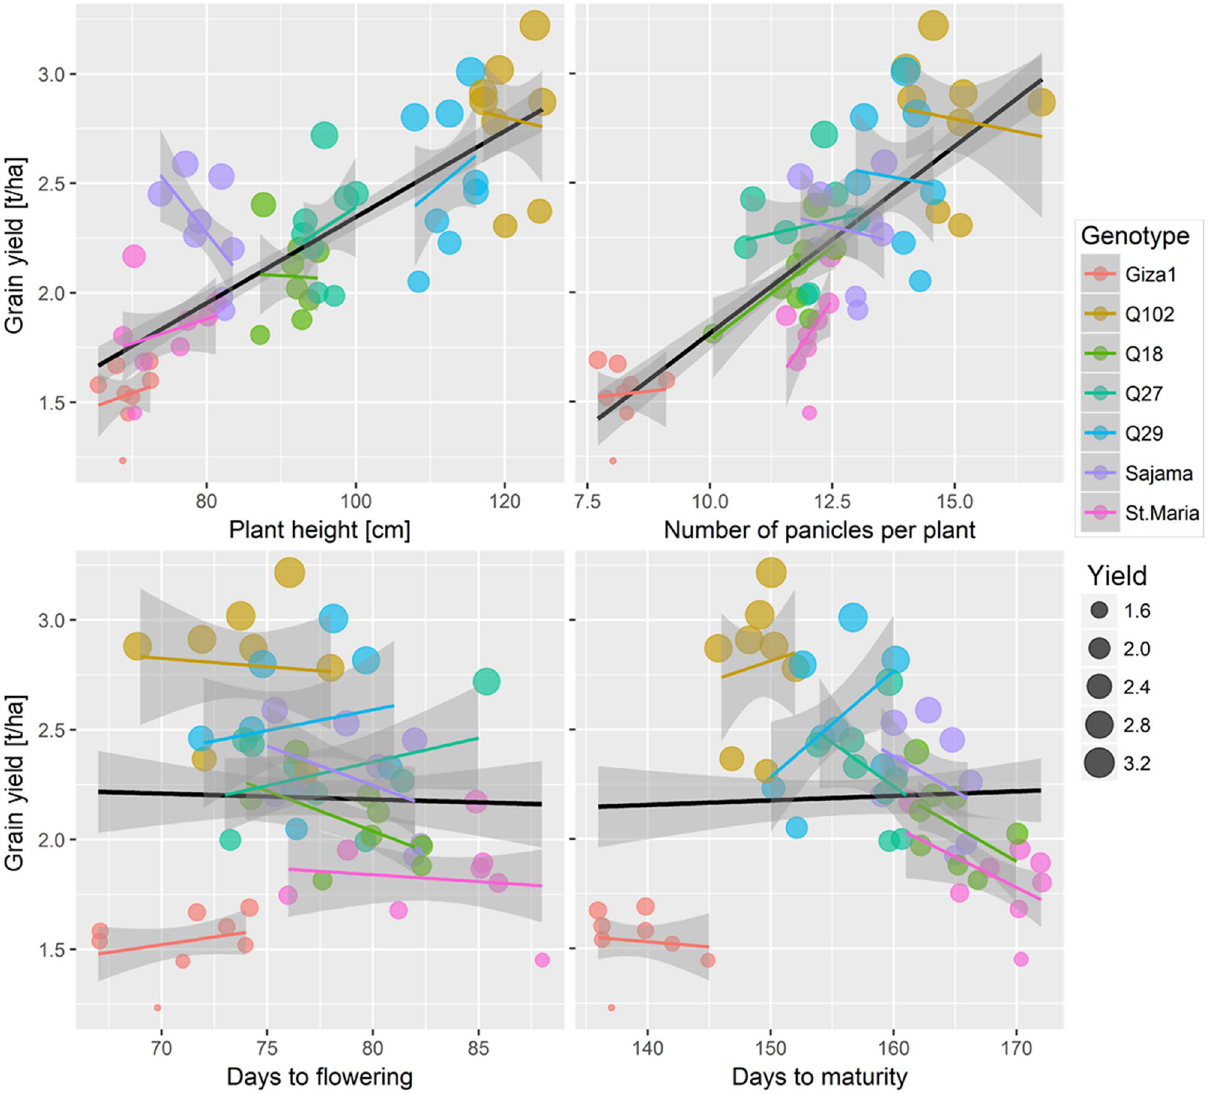
Figure 7. Relationship between grain yield, plant height, number of panicles and maturity duration for different quinoa ( Chenopodium quinoa ) genotypes grown in open field under hot-arid conditions. The color of points is mapped to genotypes, and size values are set to grain yield. The solid lines (black for all genotypes combined, colors for studied genotypes) represent a linear regression with a GLM fit, with 95% confidence regions in light